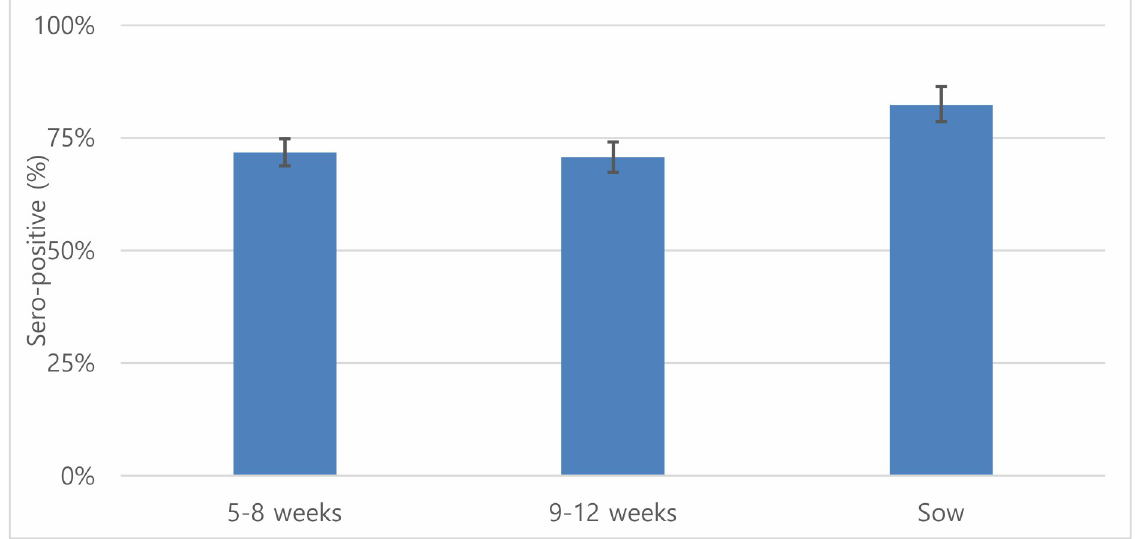
Fig 4. Seropositive rates of Japanese encephalitis with 95% confidence interval by age group in pigs.